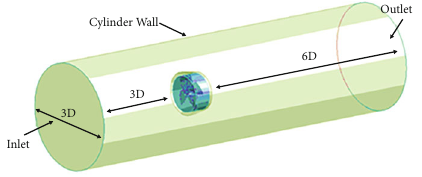
Figure 2: Dimensions of the computational domain with determination of the boundary conditions.